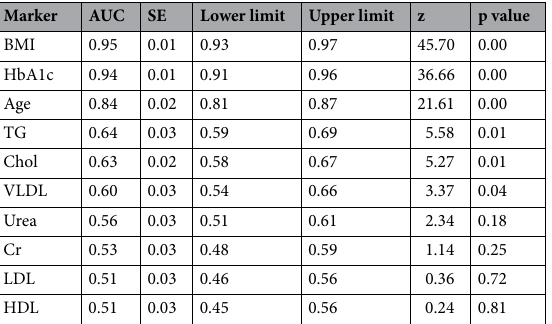
Table 2. ROC analysis to describe the predictive power of the blood biochemical markers, age, and BMI to determine diabetes incidence. Cr creatinine, Chol cholesterol, TG triglyceride, BMI body mass index.